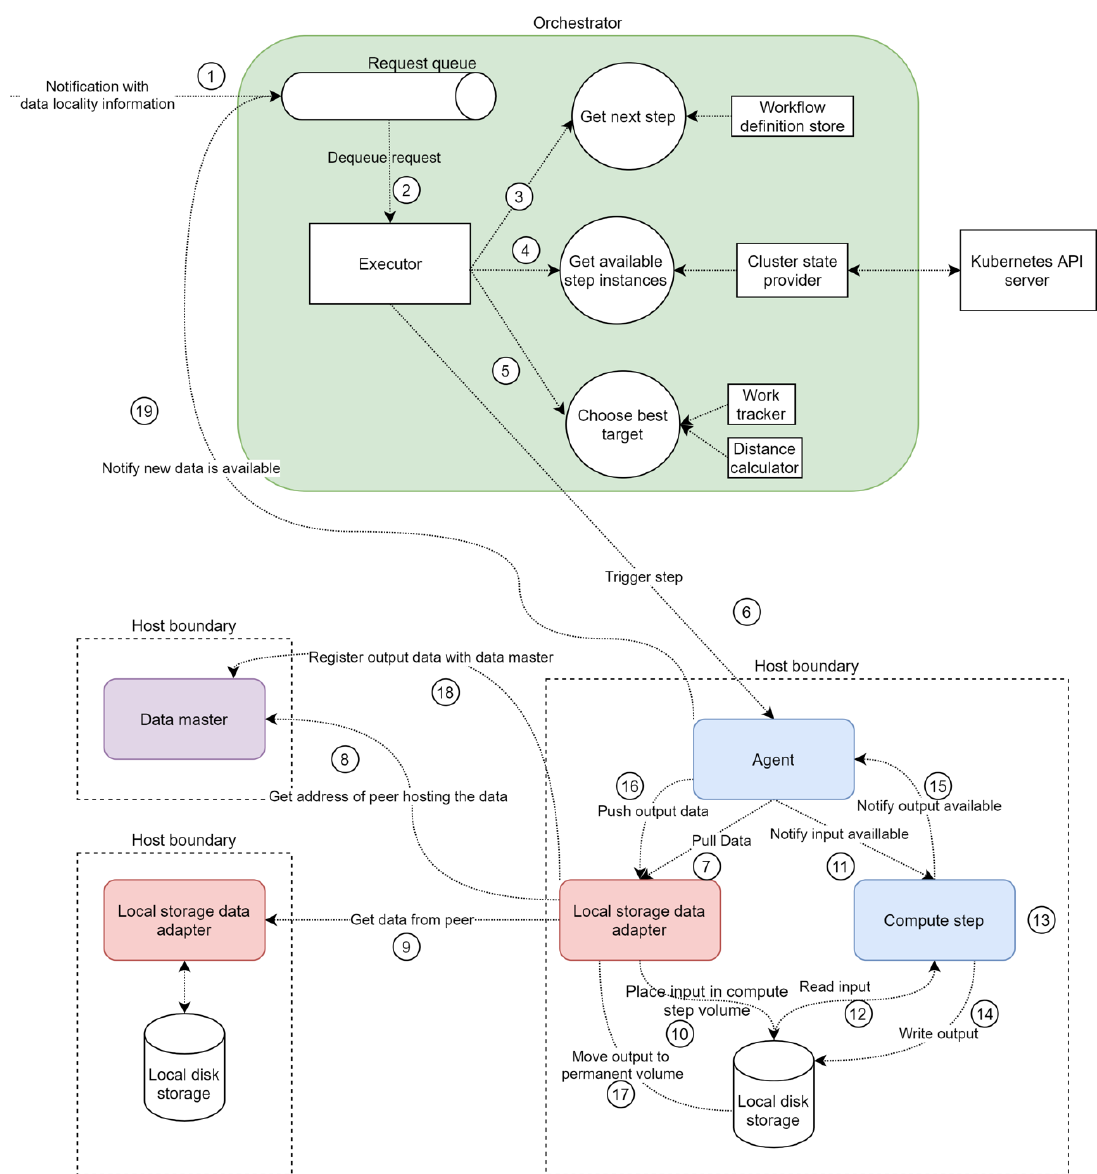
Figure 6. An example request flow in